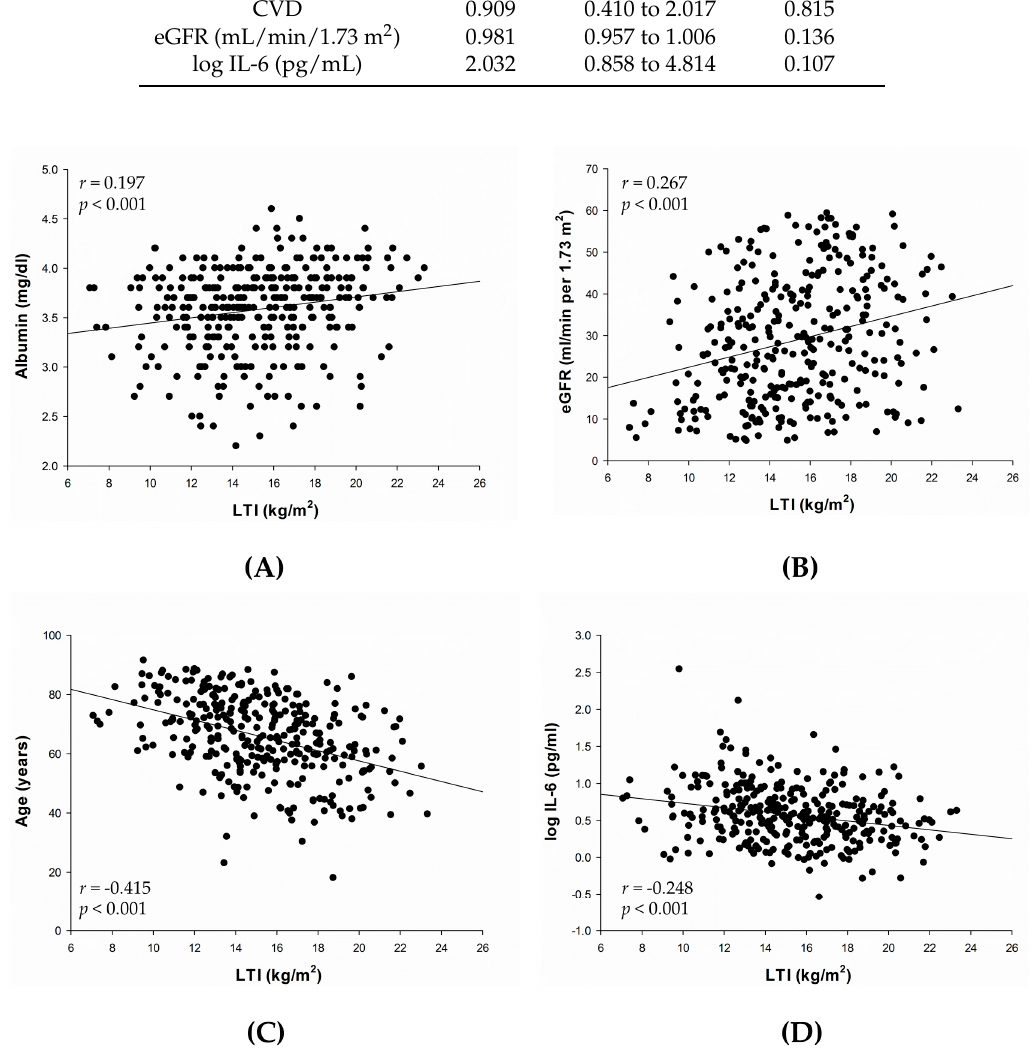
Figure 1. Univariate analysis of the correlations between LTI and serum albumin ( A ); eGFR ( B ); age ( C ); and log IL-6 ( D ). Abbreviations: eGFR, estimated glomerular filtration rate; IL-6, interleukin-6; LTI, lean tissue index.